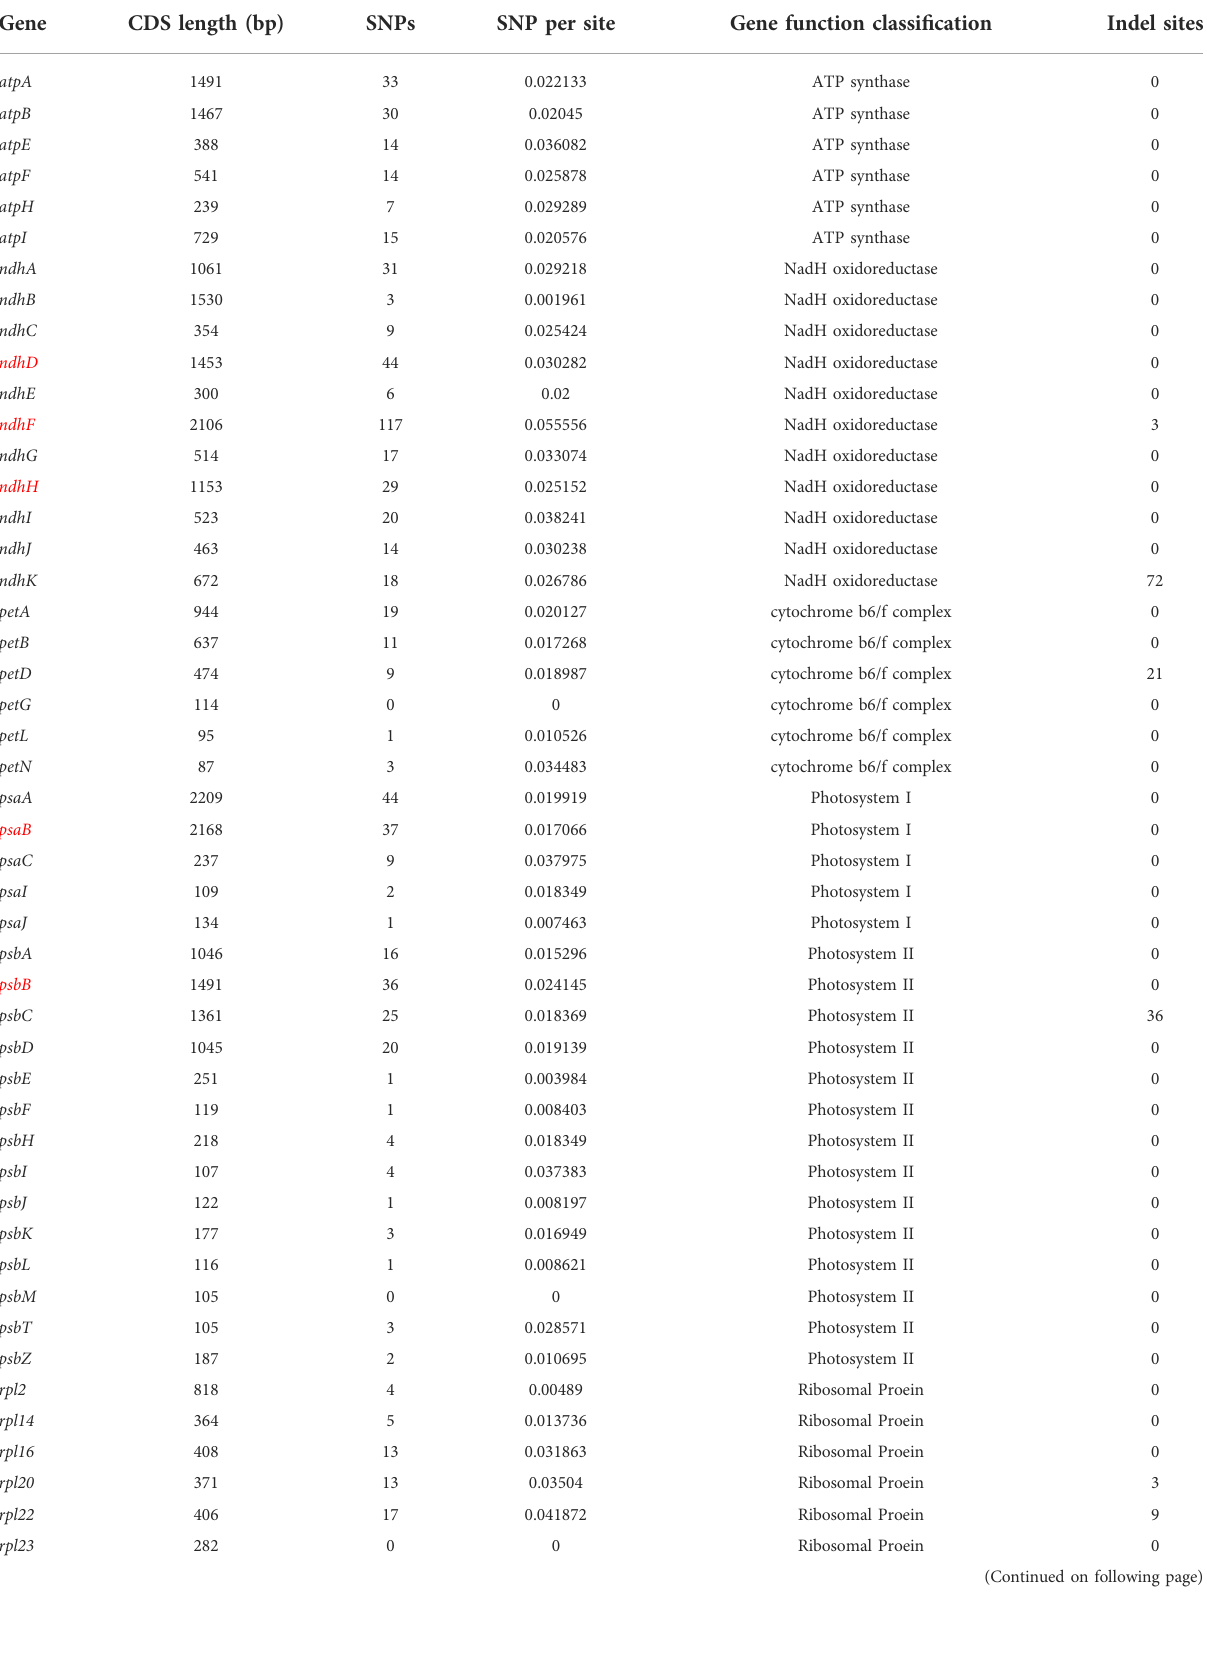
TABLE 1 The properties of protein-coding